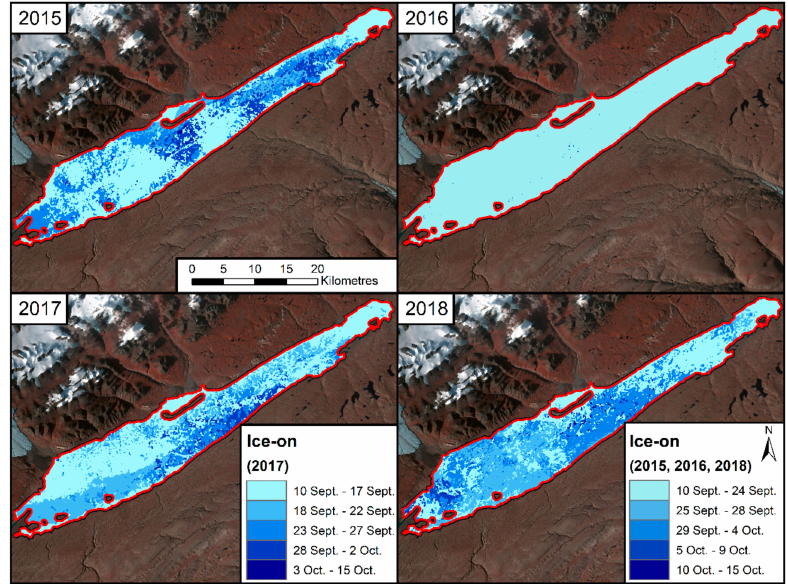
Figure 12. Ice-on dates for Lake Hazen, determined on a pixel by pixel basis using the Otsu method, from 2015–2018. Landsat-8 Level-1 image courtesy of the U.S. Geological Survey (Digital Object Identifier (DOI) number: / 10.5066 /